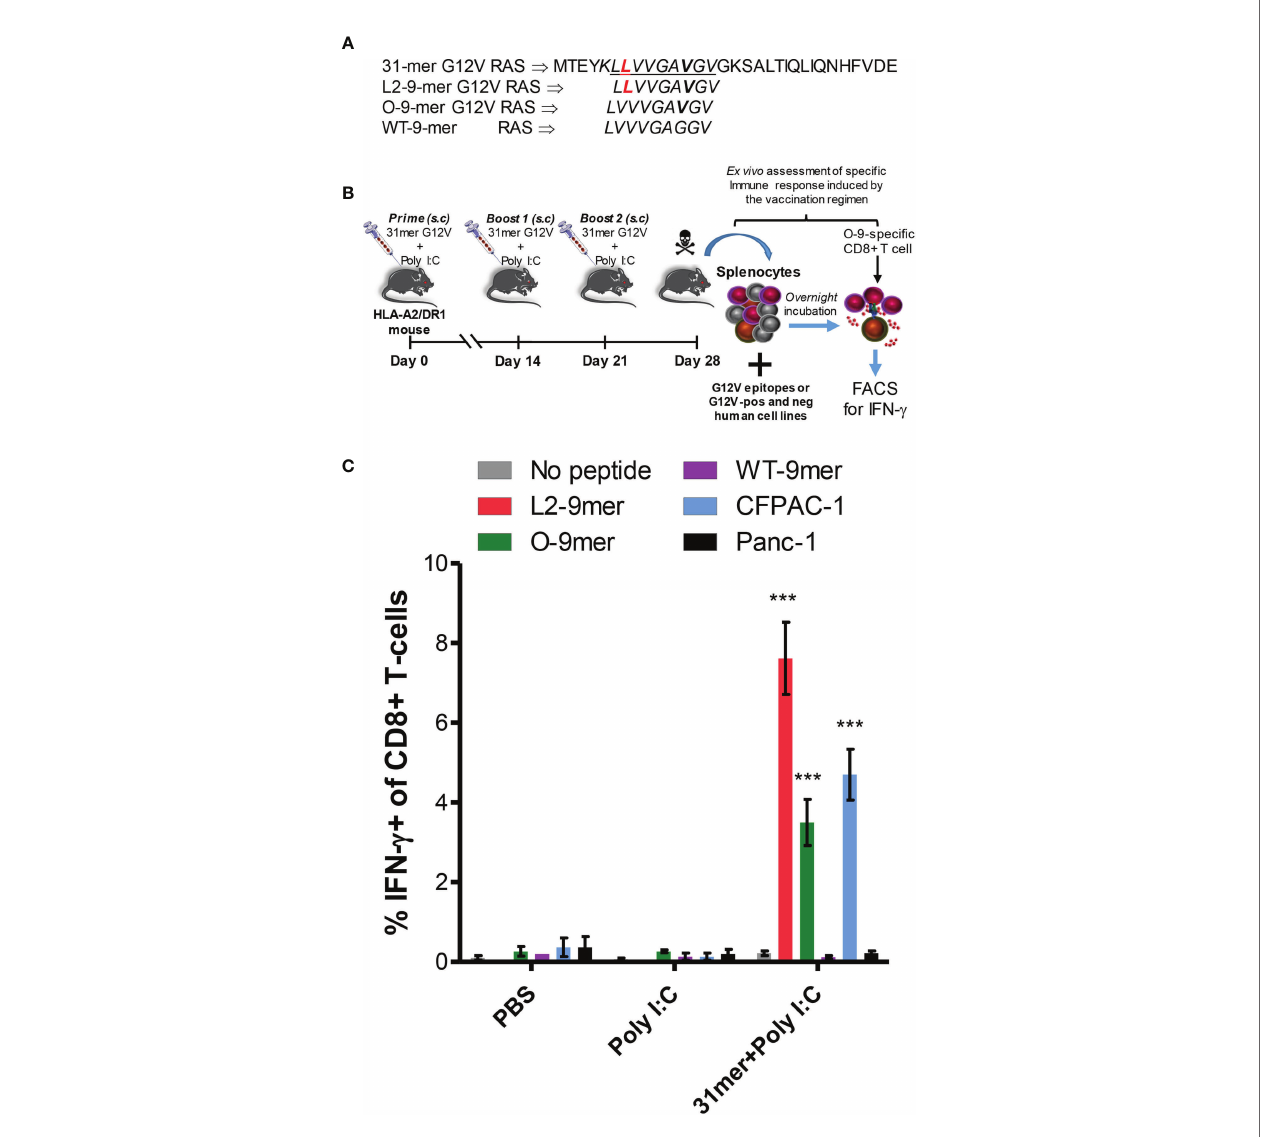
FIGURE 5 | Immunogenicity of anchor-modi fi ed G12V RAS-mutant peptide in vivo . (A) Amino acid sequence of 31-mer G12V RAS long peptide, encompassing the L2- 9-mer epitope; the L2-9-mer, O-9-mer and WT-9-mer epitopes. (B) Experimental set-up of vaccination of transgenic humanized HLA-A2/DR1 mice with the 31-mer G12V RAS peptide depicted in (A) . (C) Detection of intracellular IFN- g in CD8+ T cells by FACS was used to assess ex vivo response of splenocytes of vaccinated mice following overnight incubation with the indicated minimal epitopes, the G12V-positive/HLA-A*02:01-positive or G12V-negative/HLA-A*02:01-positive Panc-1 cell lines. The graph shows mean ± SEM of experiments performed with 3 mice per group in PBS and Poly I:C groups (controls) and 5 mice in 31mer+Poly I:C group (experimental). The data were analyzed by one-way ANOVA; ***p<